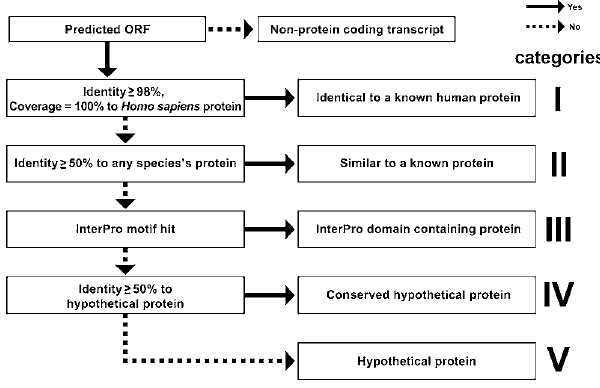
Figure 4. Schematic Diagram of Human Curation for H-Inv Proteins The diagram illustrates the human curation pipeline to classify H-Inv proteins into five similarity categories; Category I , II, III, IV, and V proteins. DOI: